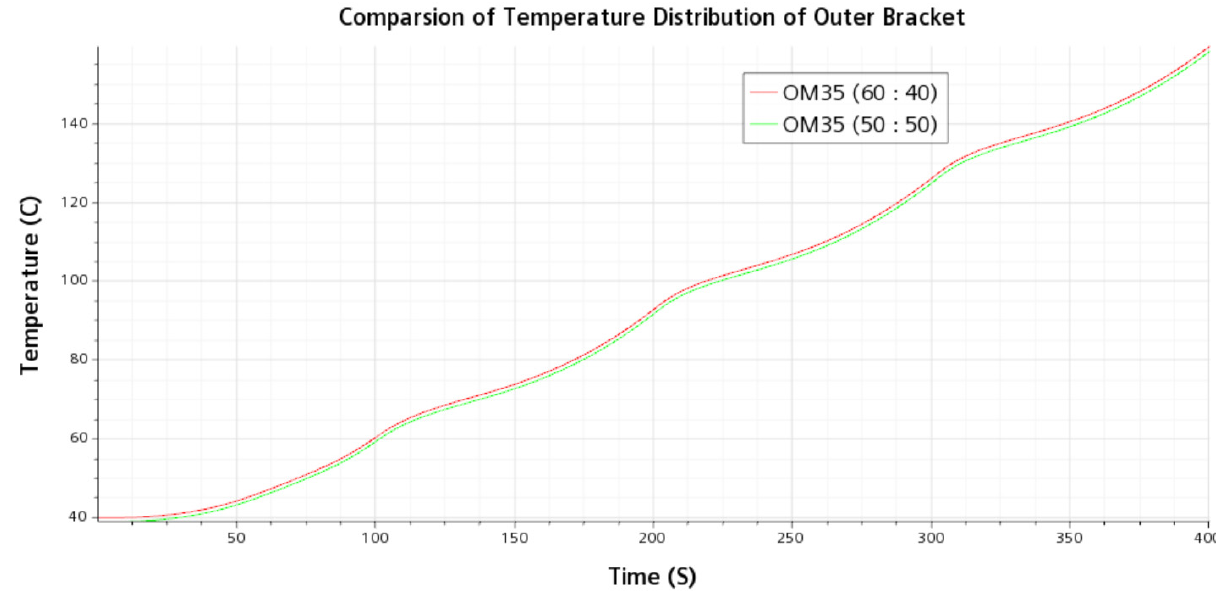
Figure 21. Comparison of temperature distribution of outer bracket plot over time for different PCM material.